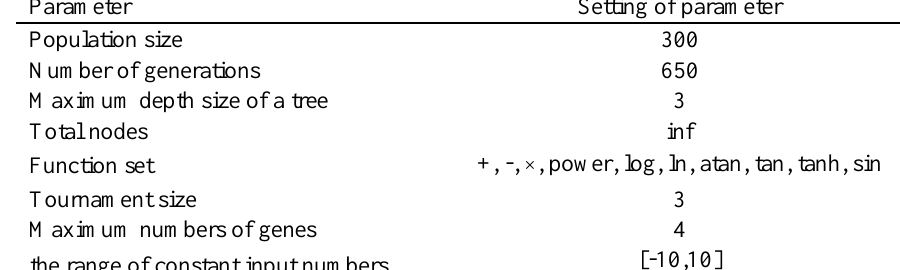
Table1. The determined parameters in the GP method